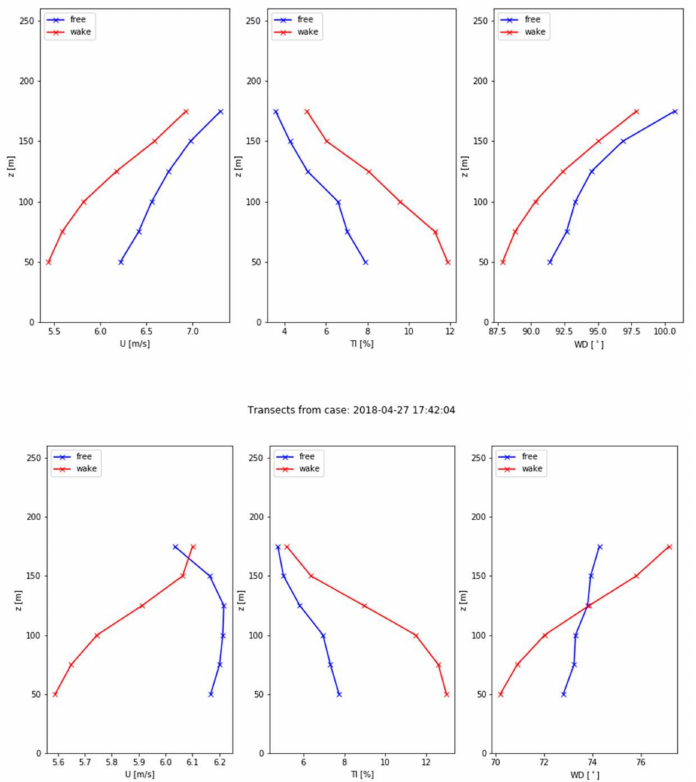
Figure 12. Profiles upstream and downstream measured by the Doppler radars. Top: Case 2 and Bottom: Case 3. From left to right: wind speed [m / s], turbulence intensity [%], and wind direction [ ◦